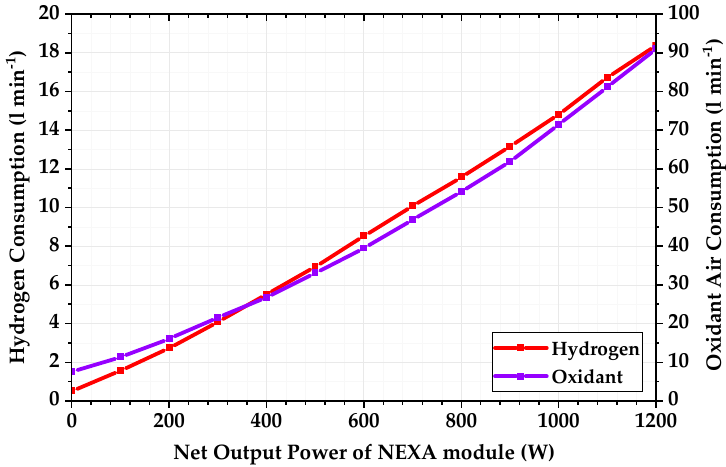
Figure 6. Fuel (hydrogen) and oxidant air consumption of NEXA FC stack.